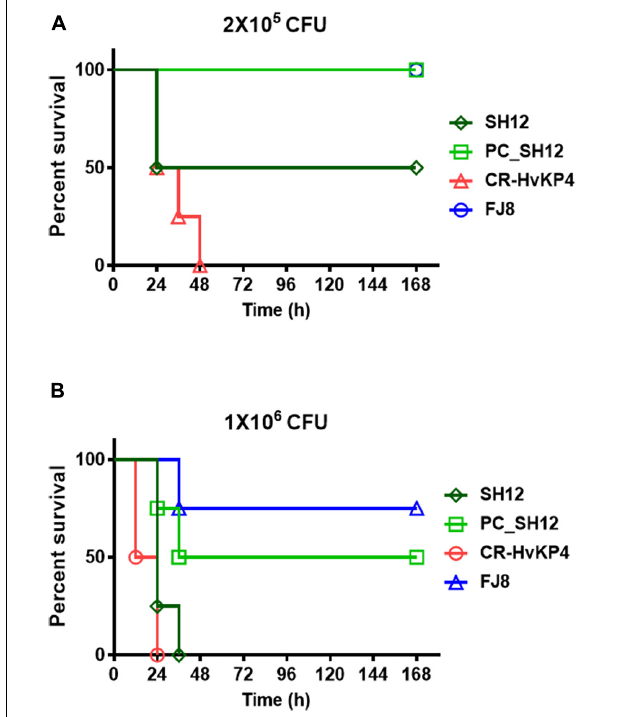
FIGURE 4 | Virulence level of different bacterial strains as depicted in mouse infection model. Survival of mice ( n = 8) infected by 2 × 10 5 CFU (A) and 1 × 10 6 CFU (B) of each K. pneumoniae strain at 168 h. The test strains included K. pneumoniae strain SH12, its virulence plasmid cured strain PC_SH12, CR-HvKP strain CR-HvKP4 (hypervirulence control), and the classic CRKP strain FJ8 (low virulence